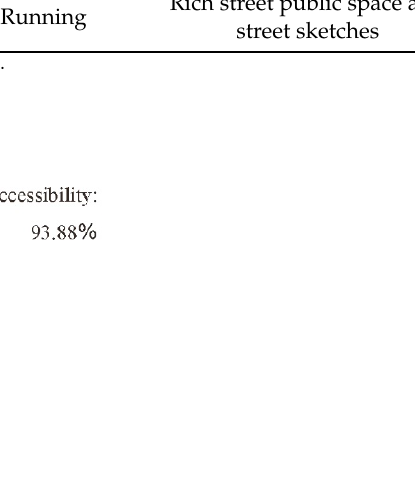
Rich street public space and street sketches